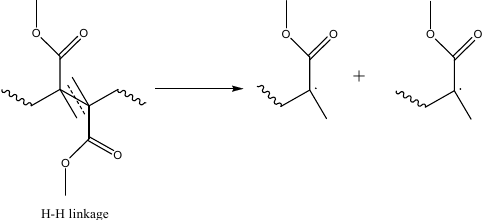
Figure 9. Second thermal degradation initiation reaction via fission at the head-head linkage formed